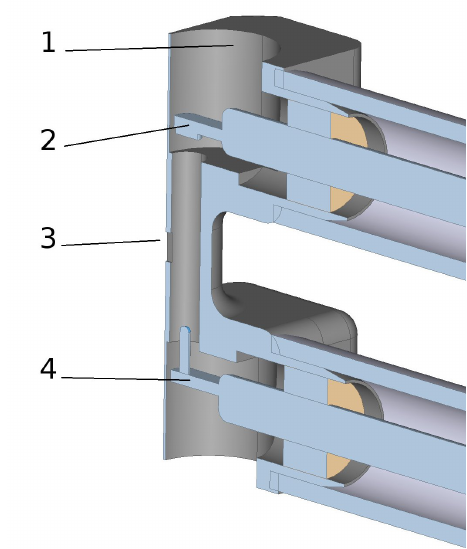
Figure 4. Scheme of the U-120M cyclotron PIG ion source. The number coding denotes the tungsten- copper body of the ion source (1), the anticathode (2), the extraction slit (3), and the cathode